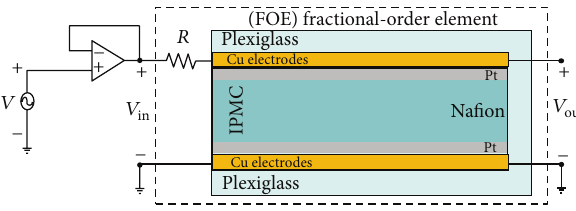
Figure 3: IPMC FOE sandwich configuration